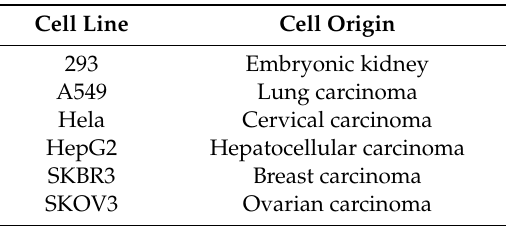
Table 1. Cancer cell line origins for the cell lines used in this research article.